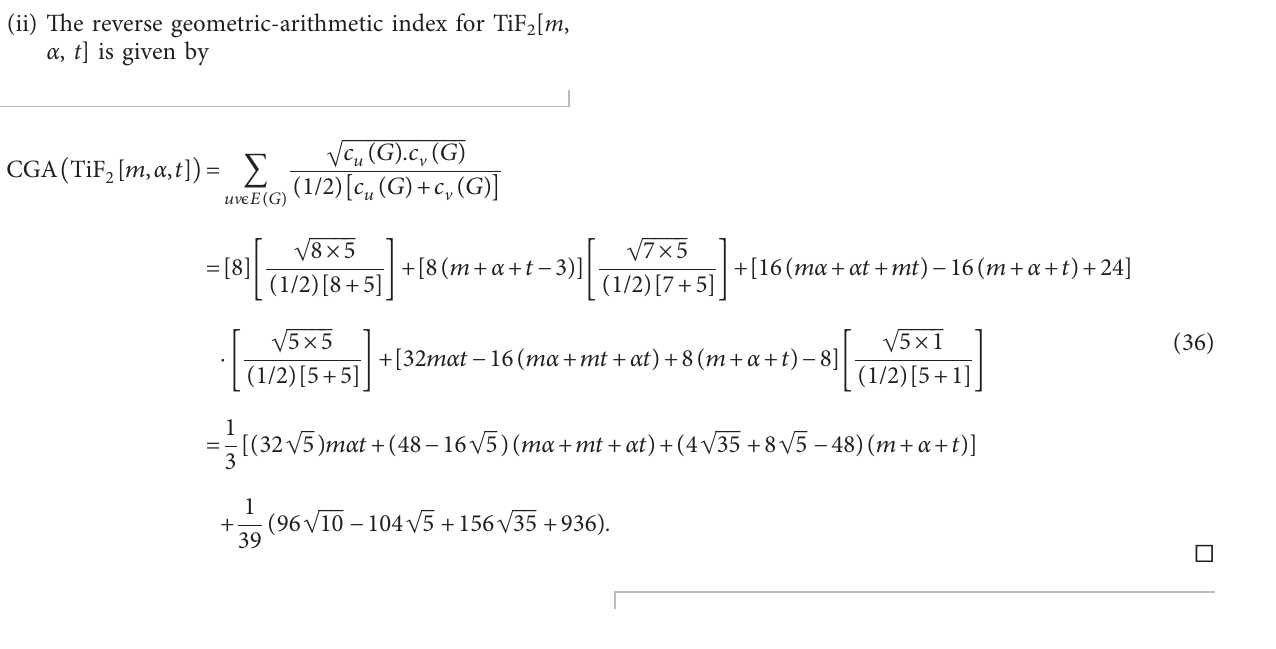
Table 2: Values of calculated topological indices of TiF